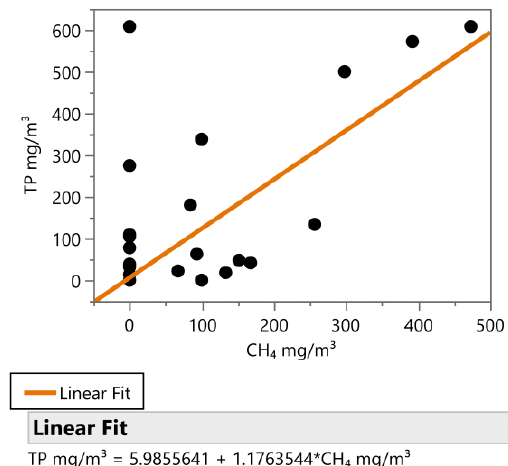
Figure 2. Regression analysis of the strongest dependencies of the studied parameters TP and CH 4 .